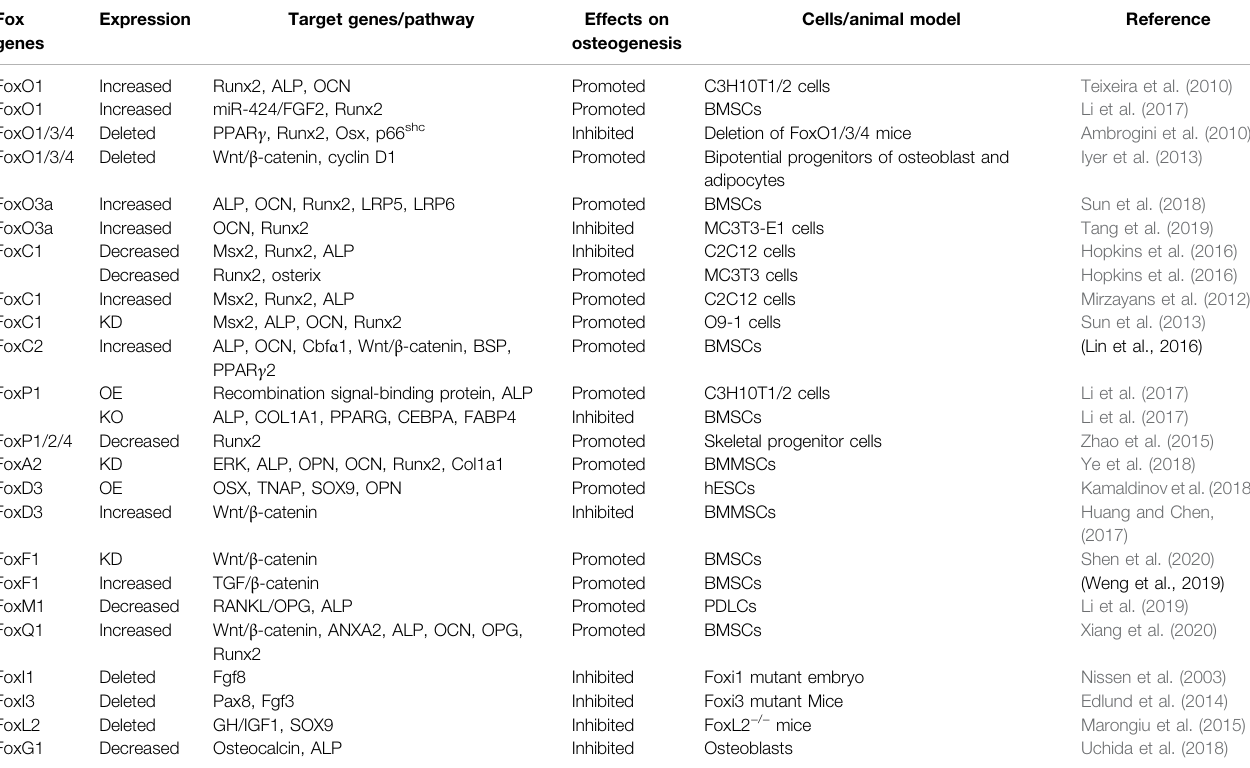
TABLE 1 | The role of the Fox subfamilies in osteogenic